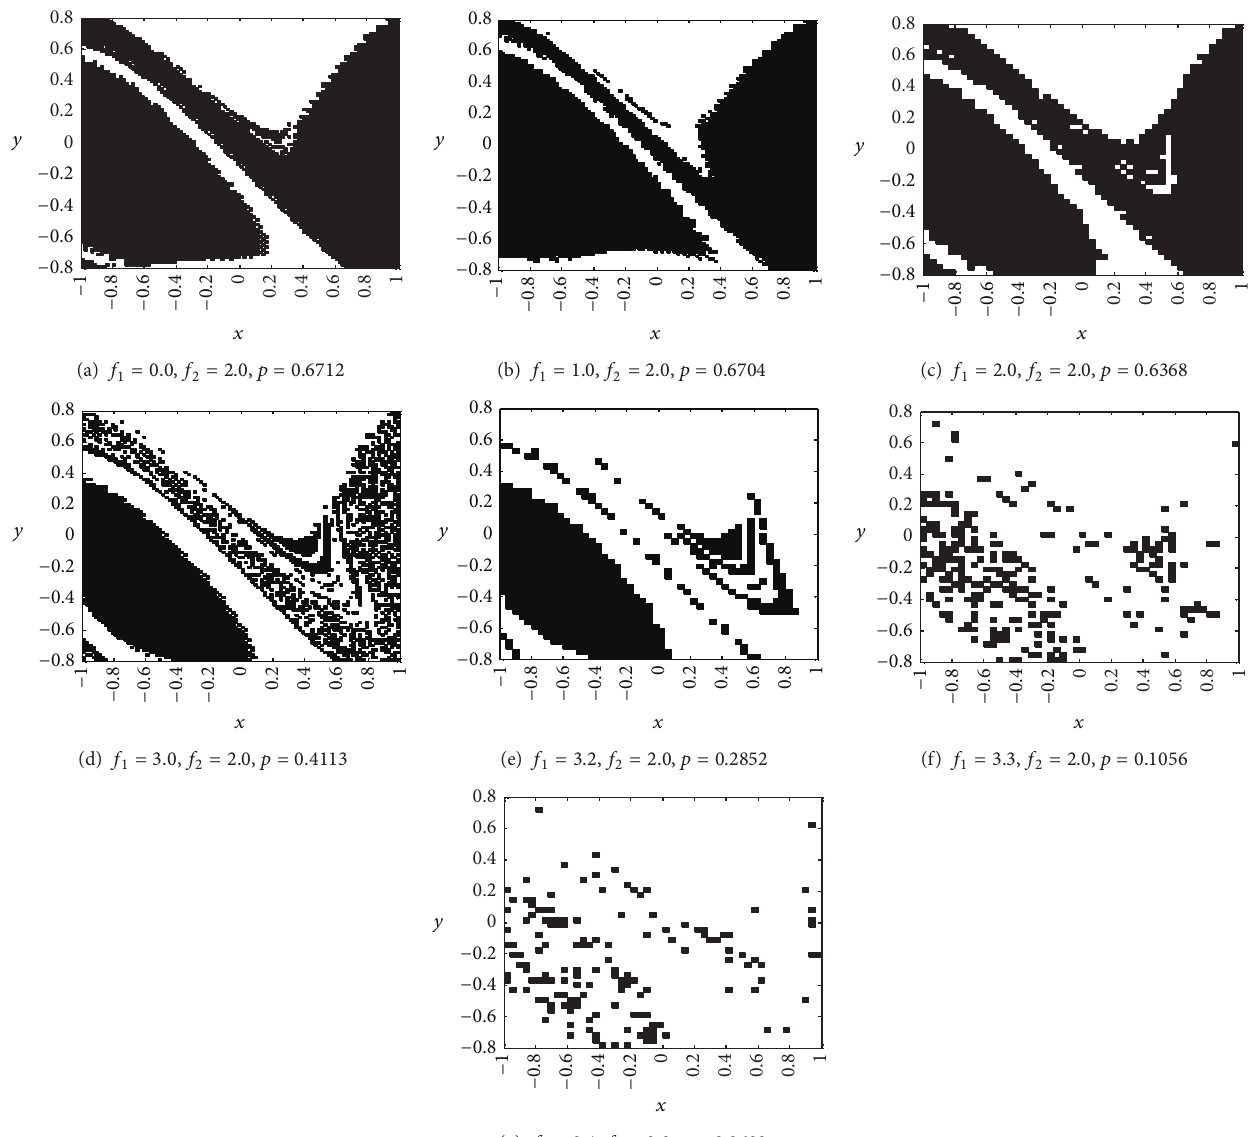
Figure 8: Erosion of safe basins in system (1): ( 𝑓 2 = 2.0